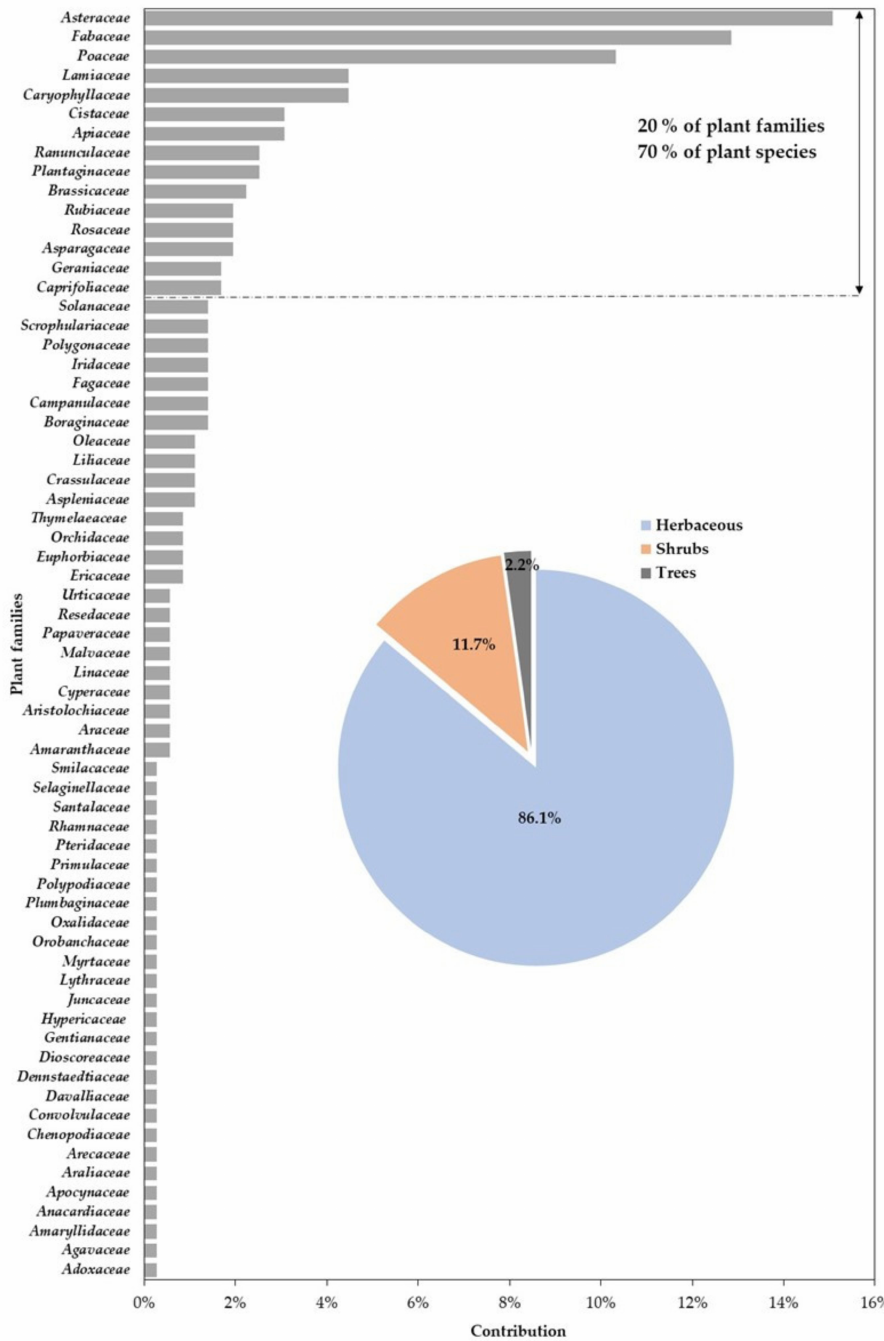
Figure 3. Diversity histogram and habitat class of plant families in the studied forest rangelands of Northern